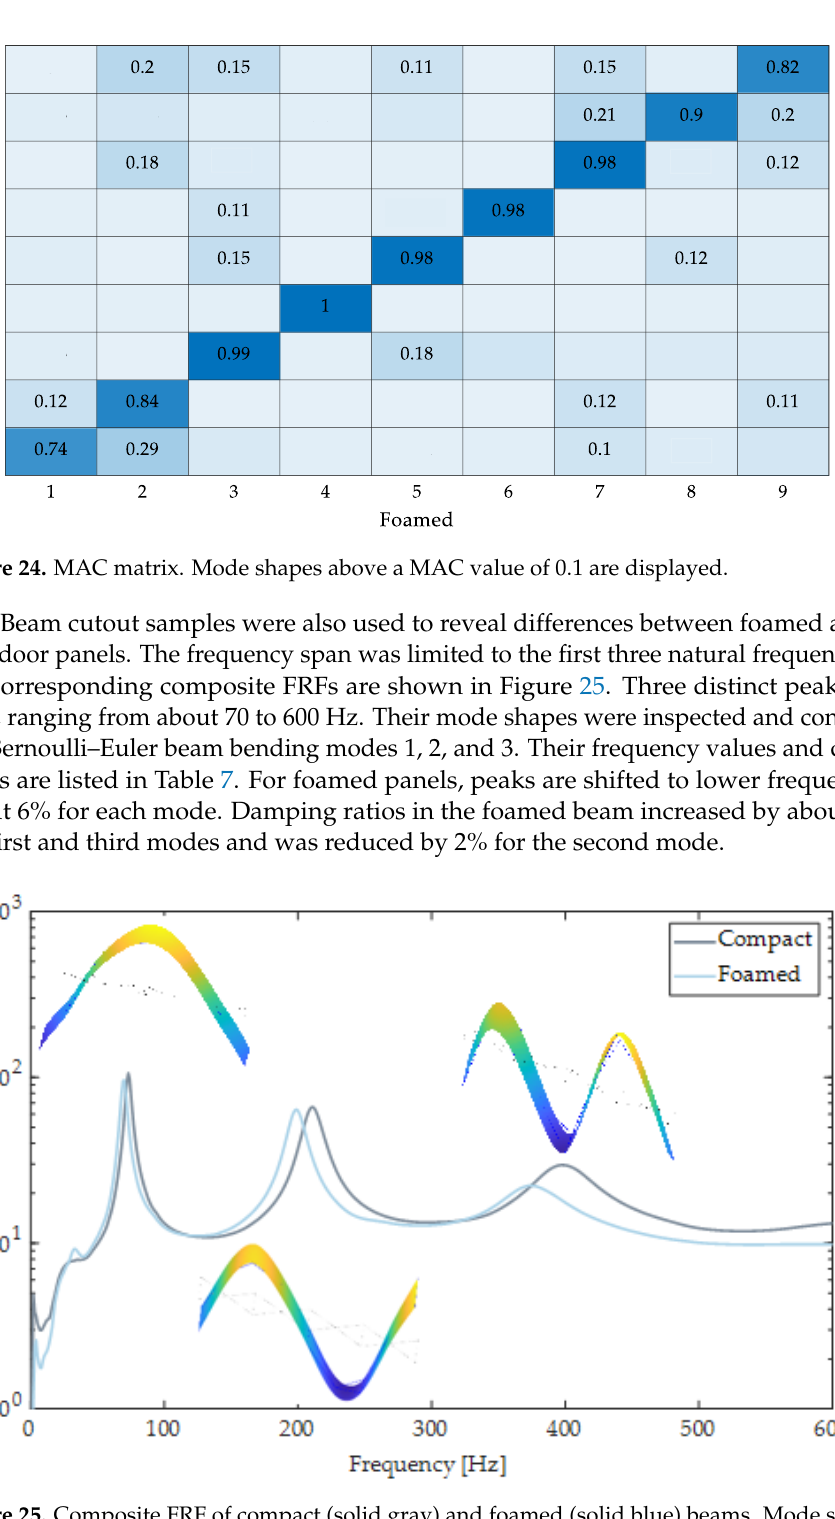
Figure 25. Composite FRF of compact (solid gray) and foamed (solid blue) beams. Mode shapes are shown for the foamed beam cut-out. Table 7. Estimated natural frequencies, mode descriptions, and damping ratios of tested composite beams. All bending modes are along the y-axis.